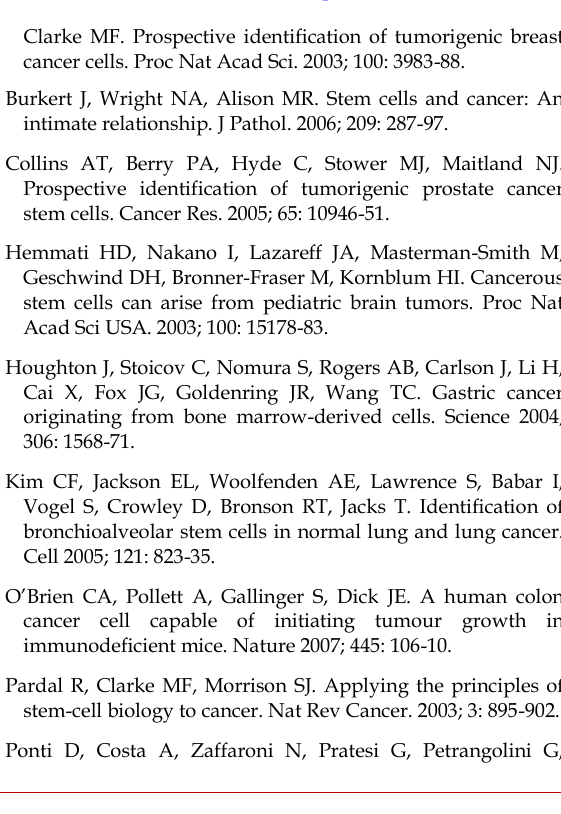
Figure 3: qRT-PCR analysis. RNA isolated from the CD90 sorted cells of liver cancer and normal tissues were subjected to qRT- PCR. Liver CSCs shows miR-34a expression in the all the liver cancer tissue samples when compared with that of